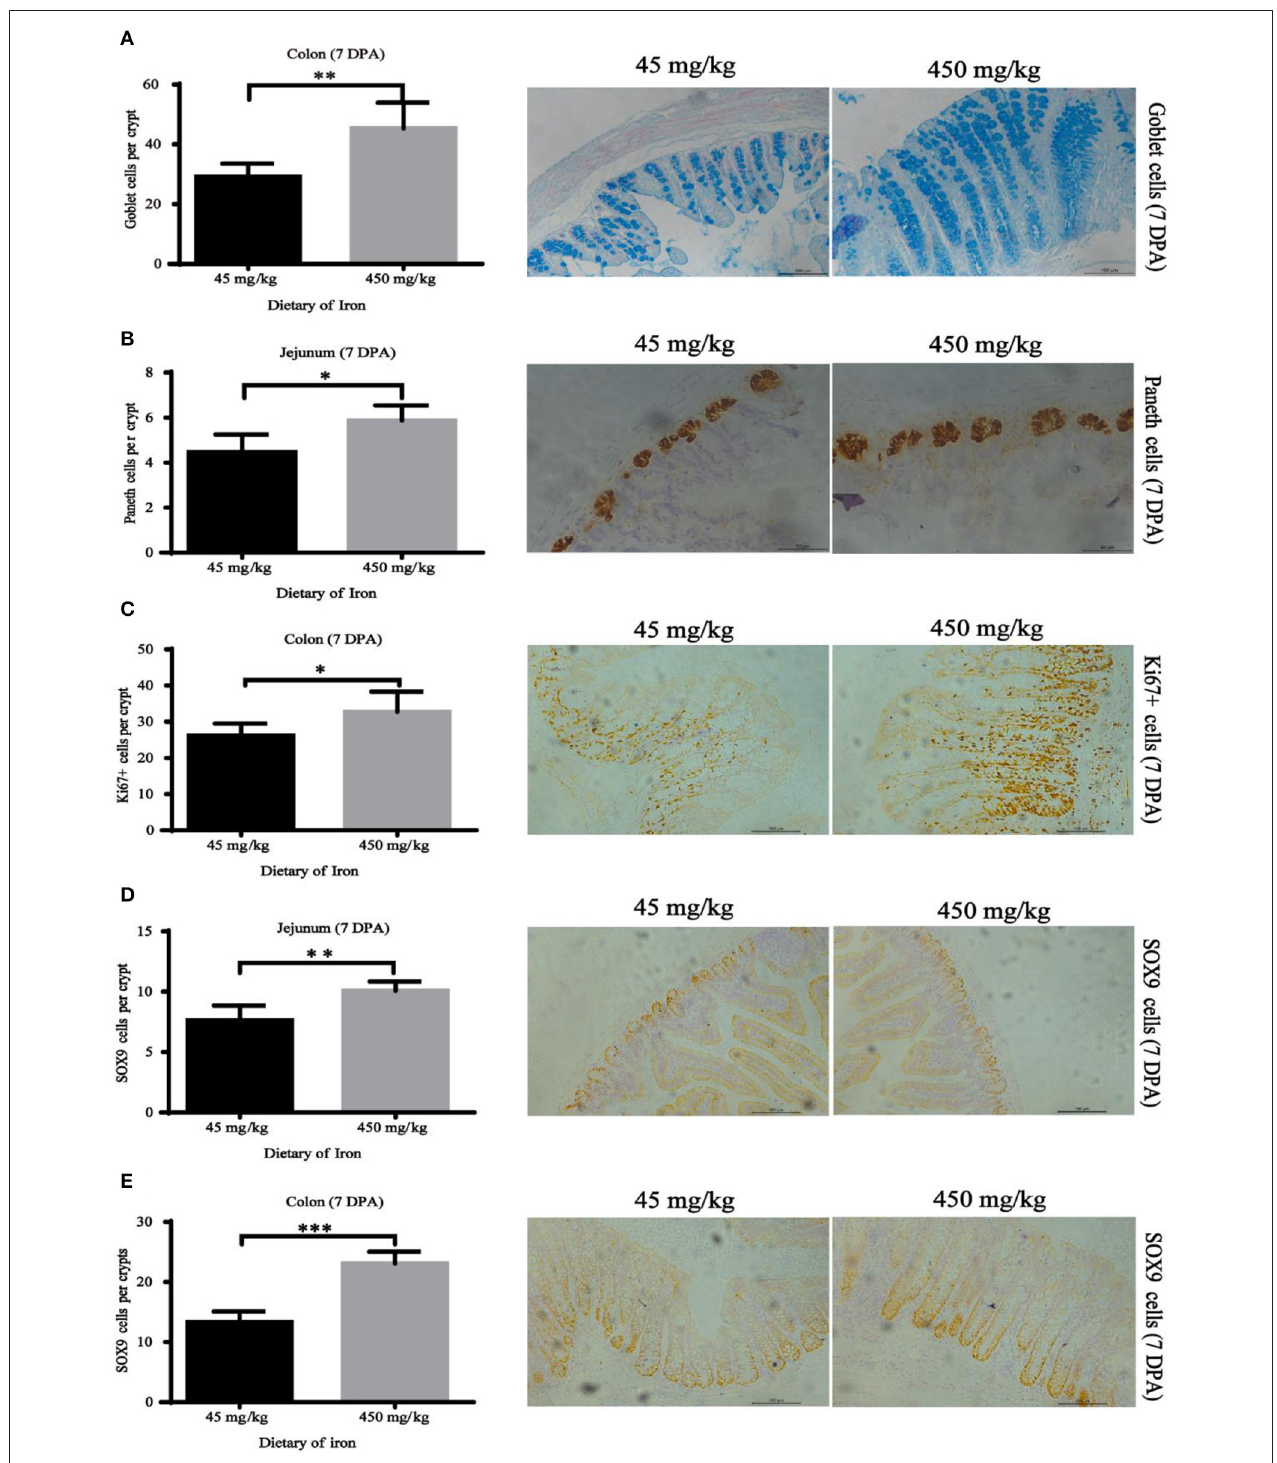
FIGURE 6 | Effects of dietary iron on regeneration of intestinal epithelial cells in adult mice at 7 DPA. (A) Goblet cells in colonic crypt, (B) Paneth cells in jejunum crypt, (C) Ki67 cells in colonic crypt, (D) SOX9 cells in jejunum crypt, and (E) SOX9 cells in the colonic crypt. n = 12. The 7 DPA indicates “day 7 post administration,” which is the day 28 of the whole experiment cycle. Note Scale bars, B used 50 µ m (magnification 400 × ), the rest used 100 µ m (magnification 200 × ). * indicates p < 0.05, ** indicates p < 0.01, and *** indicates p < 0.001.